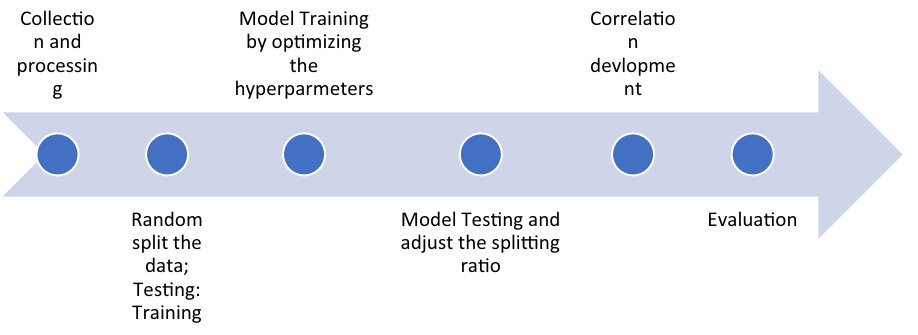
Fig. 3 Processes of building the different ML models Collec(cid:26)o